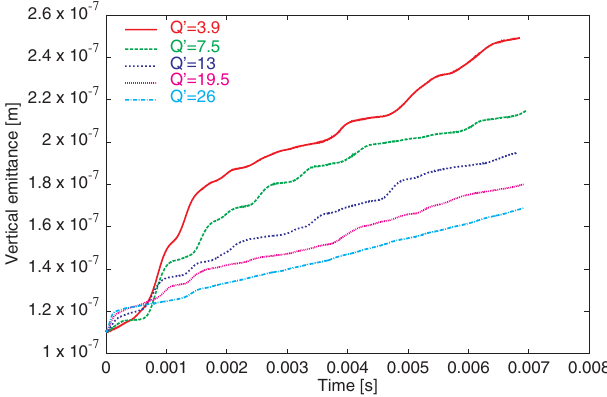
FIG. 21. (Color) Vertical emittance as a function of time for the SPS, comparing different values of vertical chromaticity Q 0 at (cid:2) (cid:2) 10 12 m (cid:4) 3 ; space charge is included here.